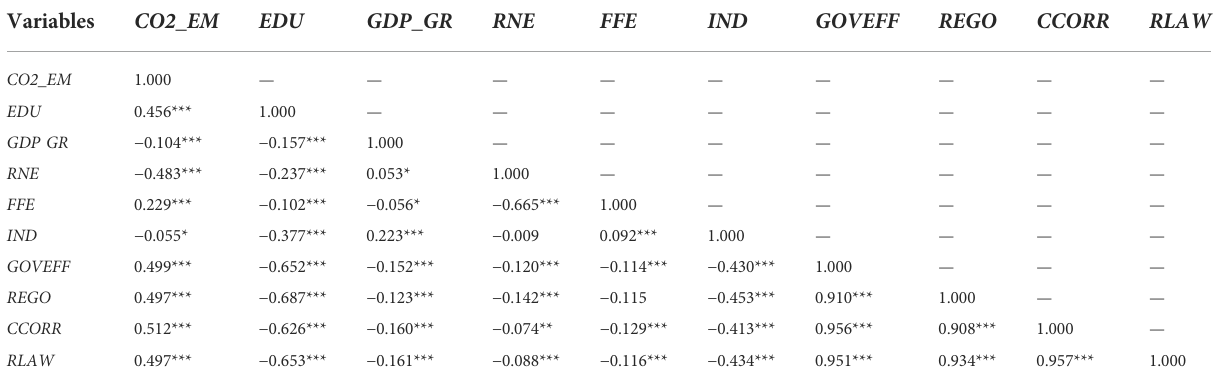
TABLE 3 Correlation matrix with signi fi cance levels.